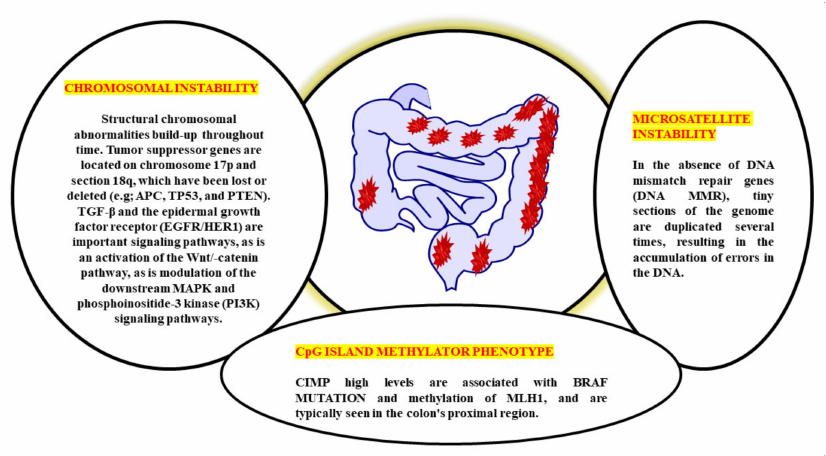
Figure 1. Multiple genetic pathways of CRC